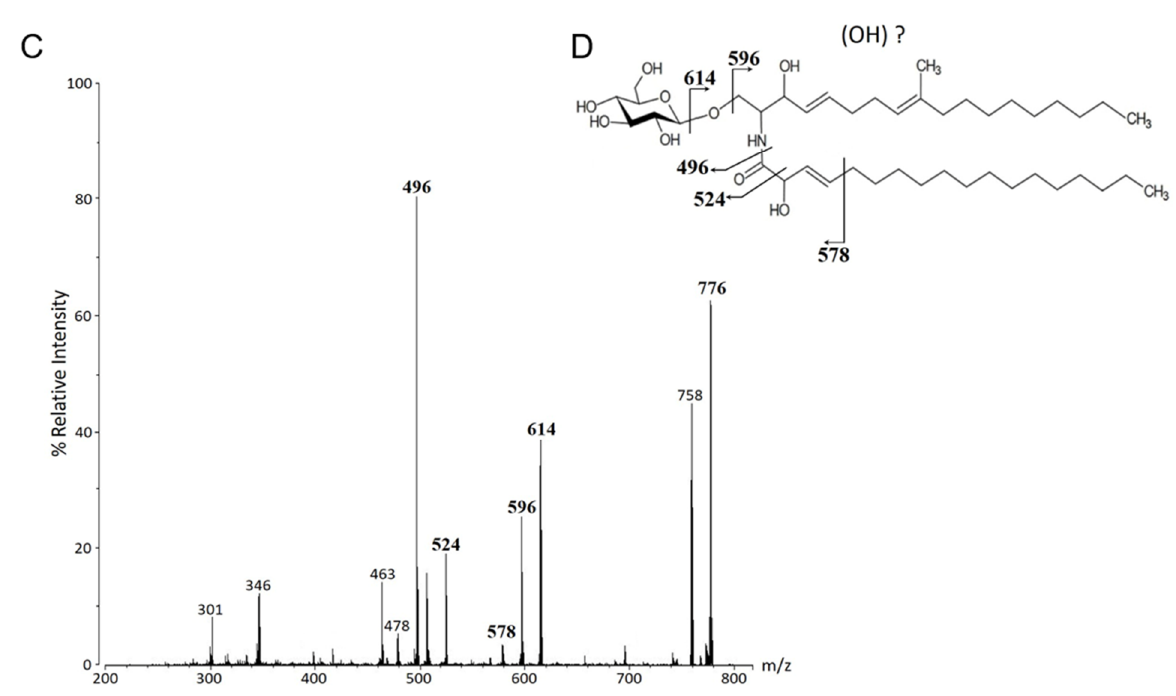
Figure 3. ESI-MS2 of the major ion species m/z 760 ( A ) and its proposed structure ( B ). ESI-MS2 of the major ion species m/z 776 ( C ) and its proposed structure ( D ). The most abundant fragments in each spectrum are in boldface. The position of an extra hydroxyl group of unspecified location is in parenthesis ( D ).